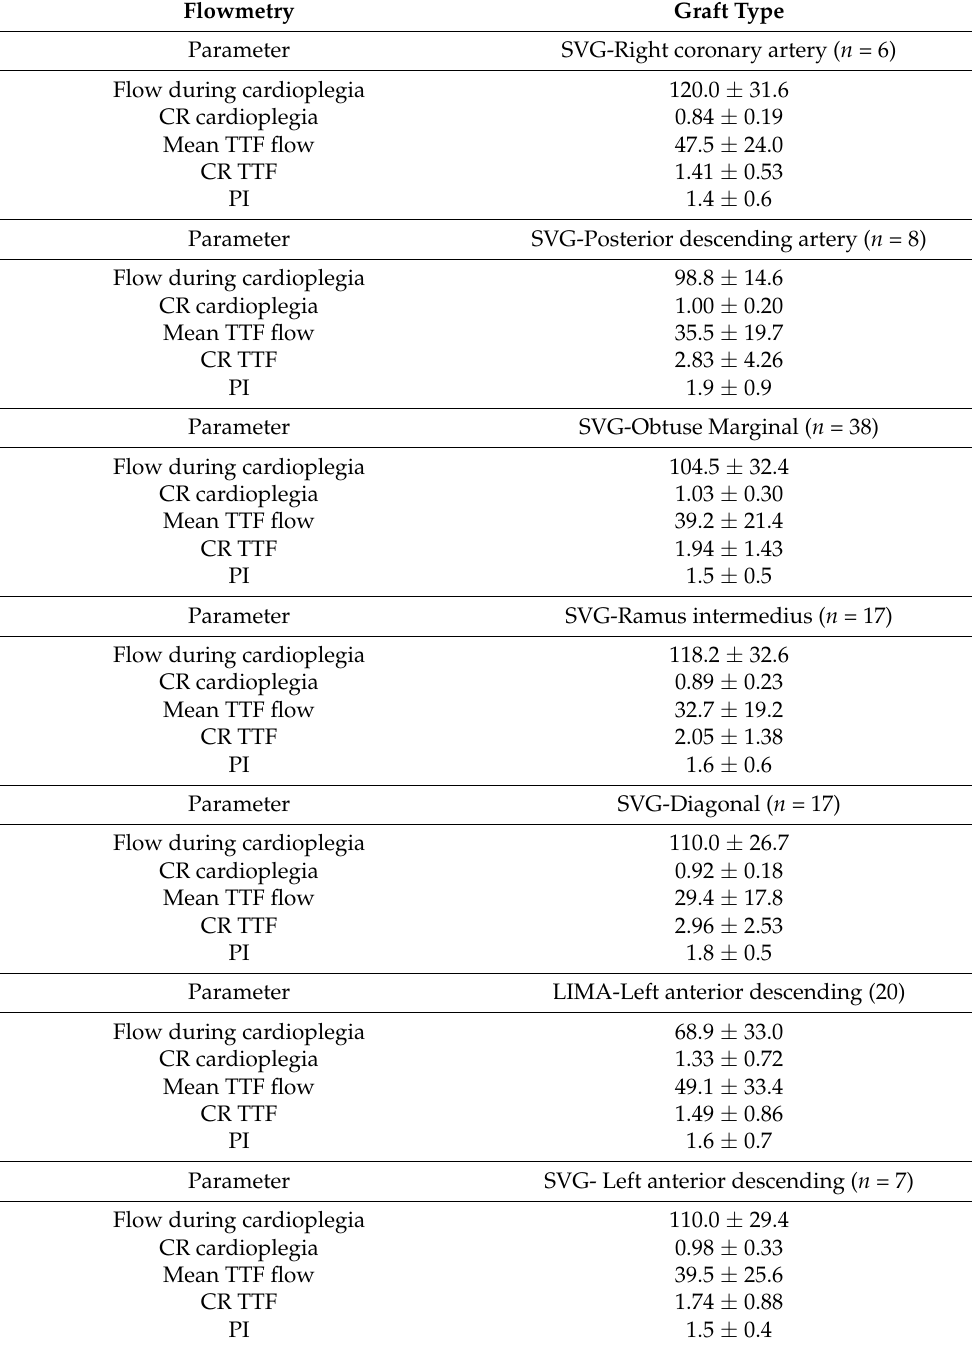
Table 2. Graft flowmetry and its derivatives stratified according to graft type and coronary